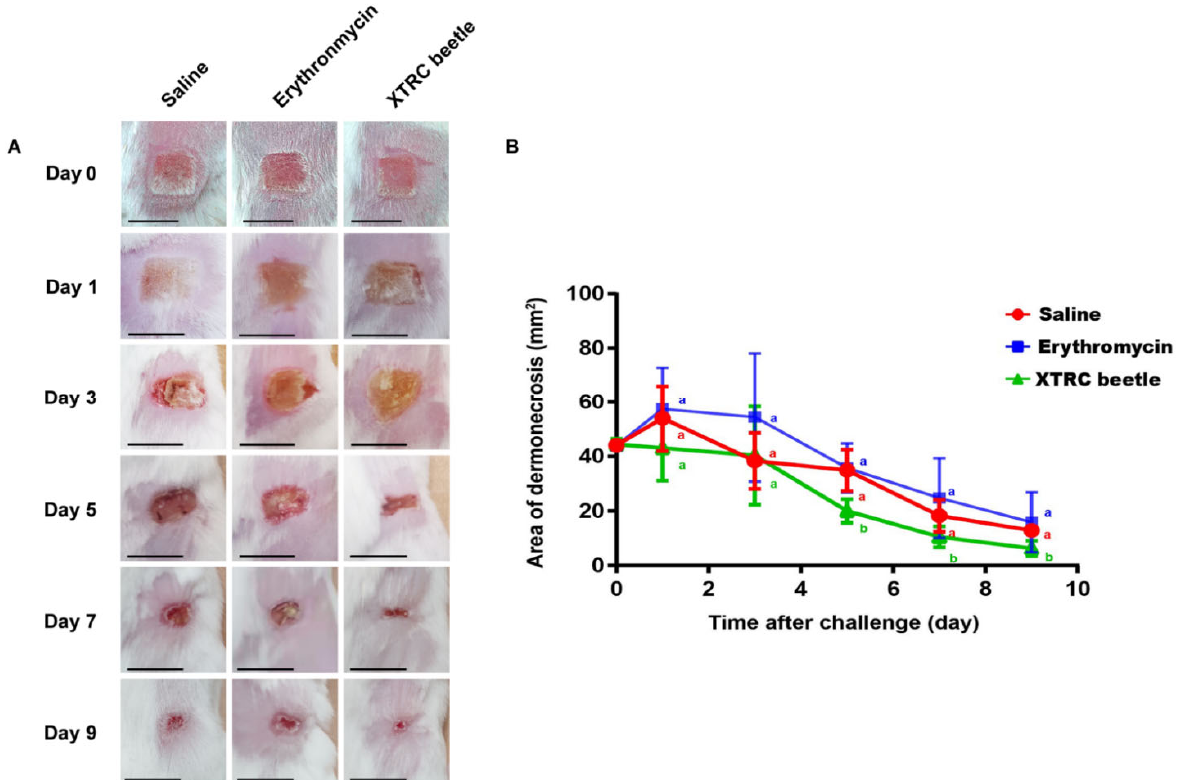
Figure 2. Wound healing and wound area measurement in thermally injured skin of mice treated with saline, erythromycin, and Z. morio hemolymph alone on days 0, 3, 5, 7, and 9. ( A ) From day 0, every other day, the wound condition of mice in each group after thermal injury and infection. Scale bars, 6 mm. ( B ) From days 0 to 9, the wound area of each group was measured with a vernier caliper every other day. Mean values at the same time point without a common superscript (a,b) differ significantly ( p < 0.05; Tukey’s test). The data are expressed as the mean ± standard error of the mean (SEM), n = 6.